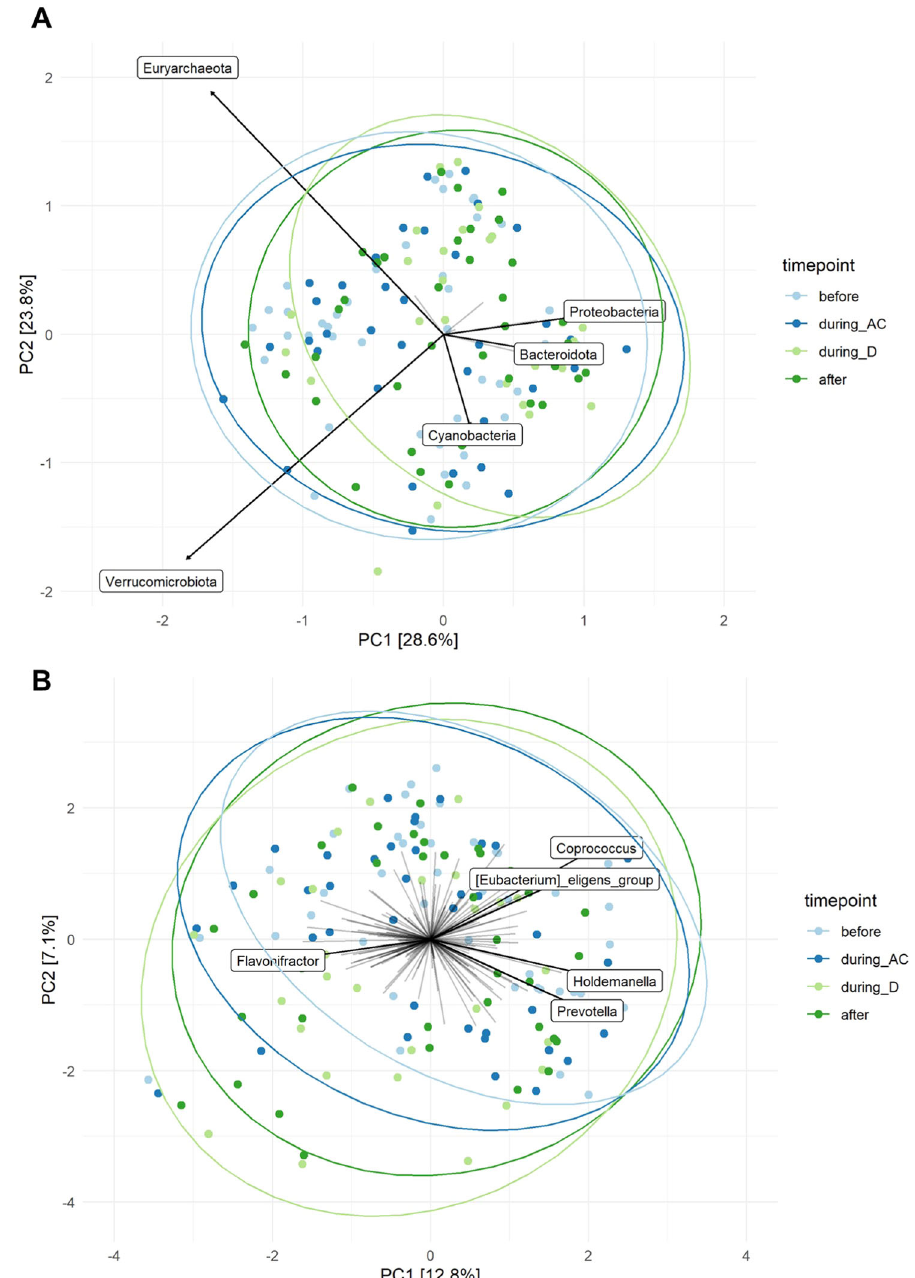
Fig. 4 Ordination plots. Ordination plots derived from unconstrained Principal Components Analysis (PCA) based on the Aitchison distance, showing the overall composition of the microbial community at phylum ( A ) and genus level ( B ) before AC-D ( n = 44), during AC ( n = 43), during D ( n = 29) and after AC-D treatment ( n = 37). Taxa that were present in less than fi ve samples were excluded from this analysis. Data were transformed using centre-log-ratio transformation. Names are given for taxa, which contributed most to overall microbial